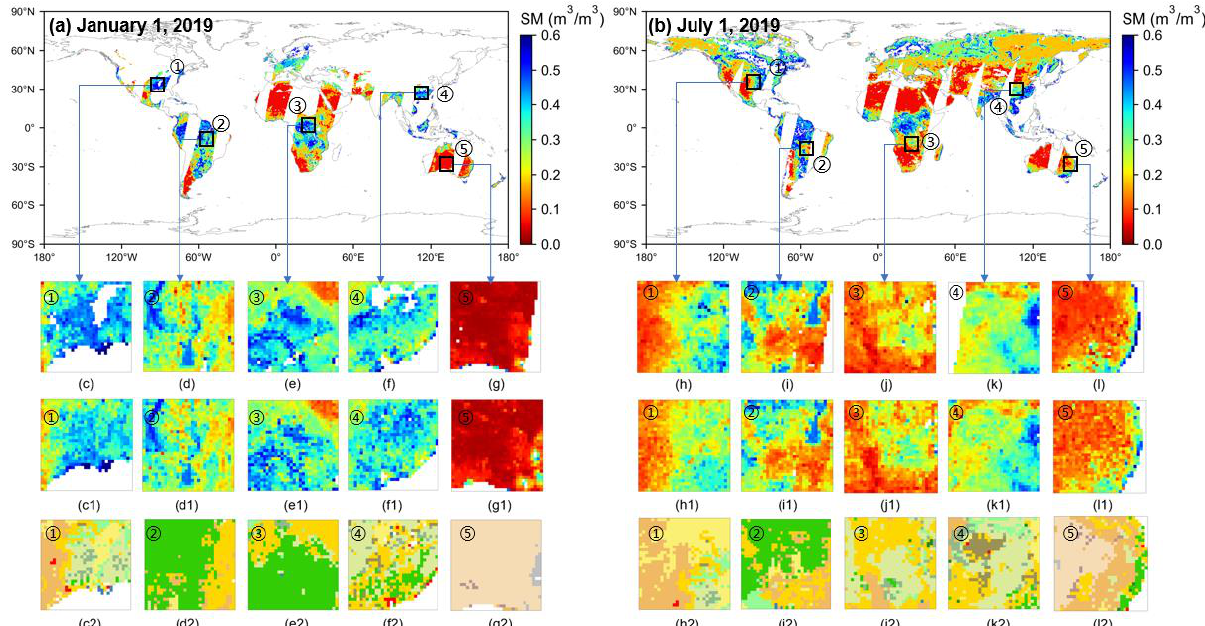
Figure 9. Comparison of the simulated soil moisture results with the original values in the manually eliminating regions on 1 January 2019 and 1 July 2019, with original global SM ( a,b ). The original SM ( c–l ), reconstructed SM ( c1 – l1 ) and land cover type ( c2 – l2 ) spatial information of ten simulated regions, respectively. The legend of the land cover type is the same as for Figure 2.